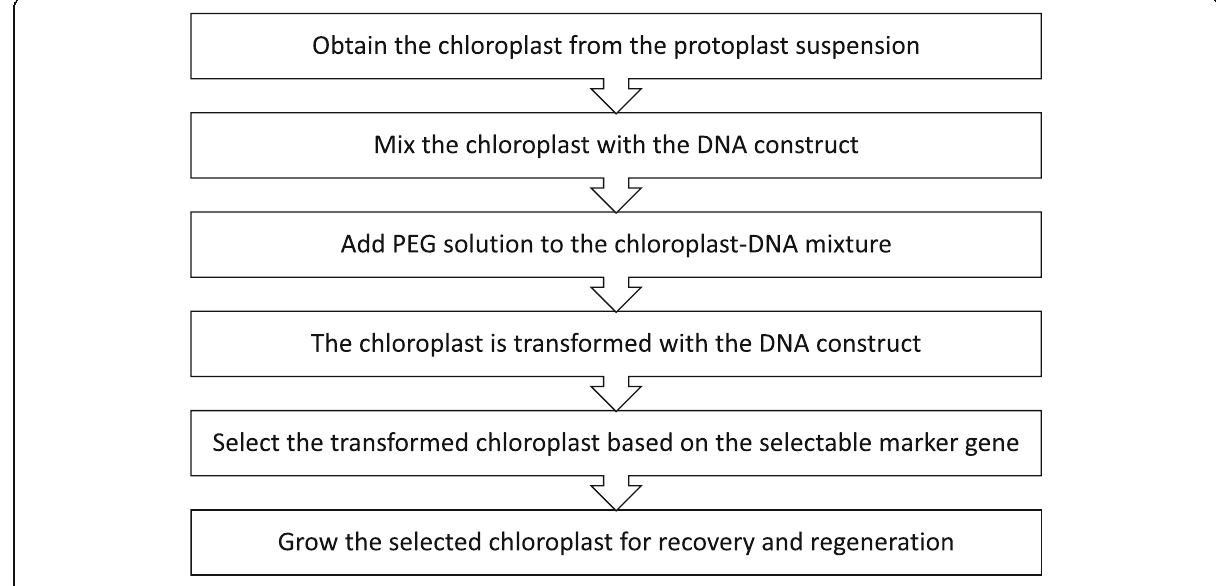
Fig. 3 Flow chart that summarizes the steps involved in PEG-mediated